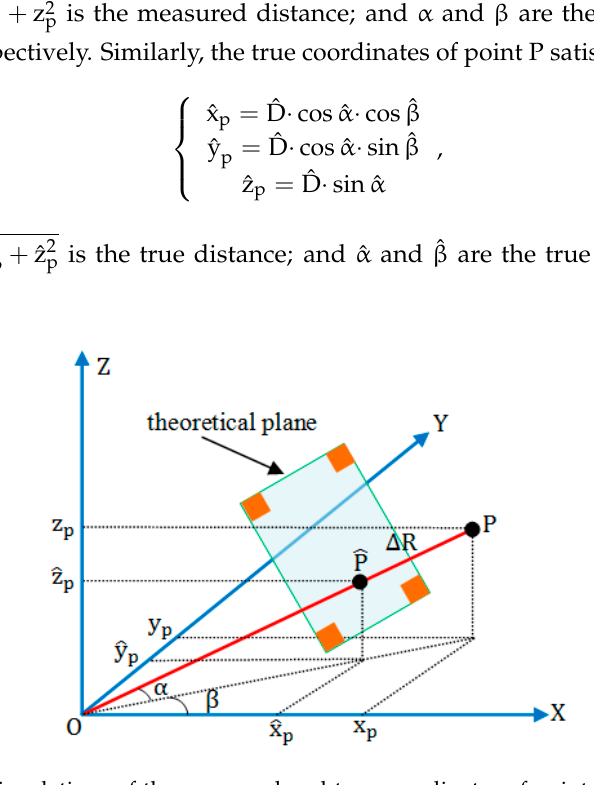
Figure 1. Geometric relations of the measured and true coordinates of point P and the theoretical plane. O is the center of the TLS. The four yellow parts are used to determine the theoretical plane. The surface of the four yellow parts is rough, and their specular reflections are subtle. Compared with the distance errors caused by specular reflection, those of the four parts can be ignored.